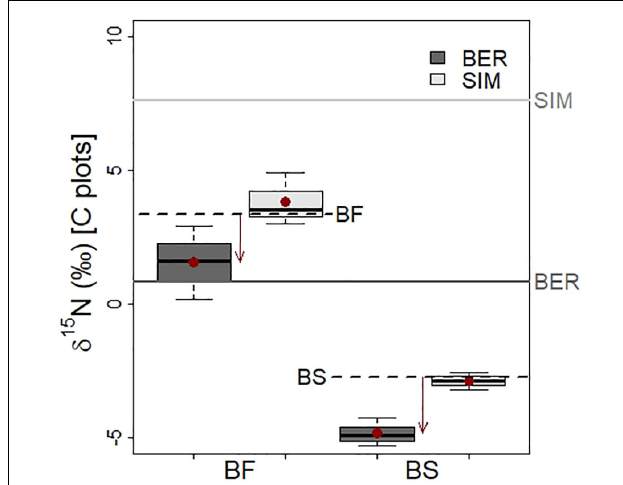
) in balsam fir (BF) and black spruce (BS) seedlings FIGURE 7 | Foliar δ 15 N ( harvested from the control plots (no warming and no N addition) 2 years after (cid:104) planting at the BER and SIM sites. The red circles are mean δ 15 N values and the horizontal dotted lines show the foliar δ 15 N average values for BF and BS seedlings prior to planting in the field. Horizontal full lines show the average forest floor δ 15 N values at BER and at SIM. Arrows show the changes in mean foliar δ 15 N after 2 years in the field.